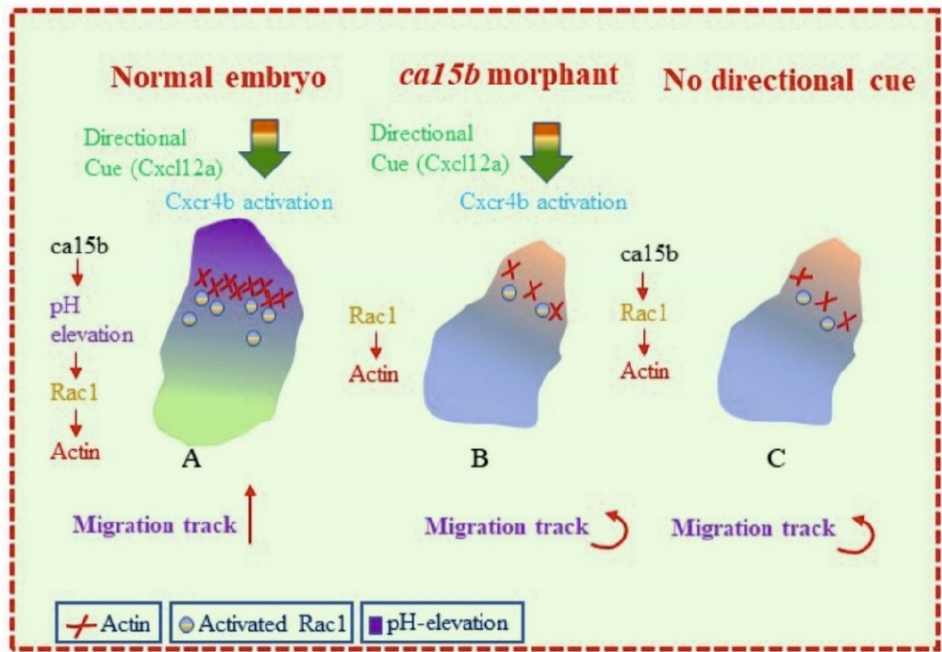
Figure 2. Proposed role of ca15b in the developing zebrafish embryos: ( A ) In the developing embryos, the migrating progenitor cells elevate pH due to CA enzymatic activity of ca15b at the cell front in response to chemokine signaling by C-X-C motif chemokine 12 (Cxcl12a). The increased pH at the cell front helps in maintaining the cell polarity. The elevated pH increases the activity of Rac1 and actin polymerization at the cell front. ( B , C ) In the absence of either ca15a activity or directional clue by Cxcl12a, no migration of the PGCs occurs in the developing zebrafish embryos. (Cxcr4b: Chemokine (C-X-C motif), receptor 4b. This protein shows a G protein-coupled chemoattractant receptor activity and plays role in several processes, including gamete generation). (The image was remade based on the graphical abstract by Tarbashevich et al. [38].